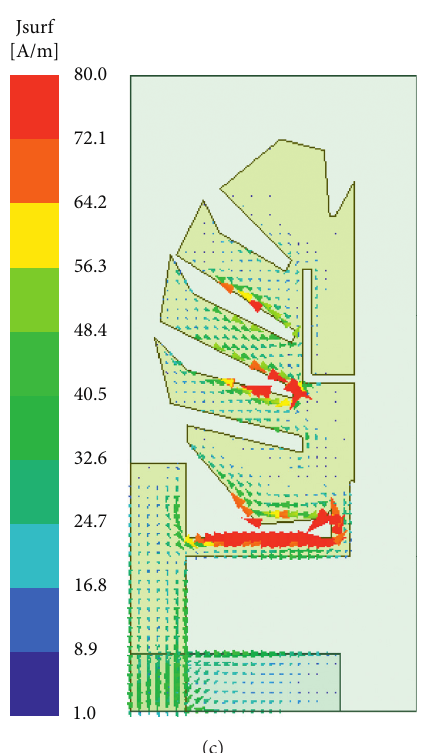
Figure 15: Distribution of surface current on Monstera deliciosa -leaf BioAs-MPA antenna at: (a) 2.6GHz (TM mode) (c) 5.5GHz (TM mode). 010